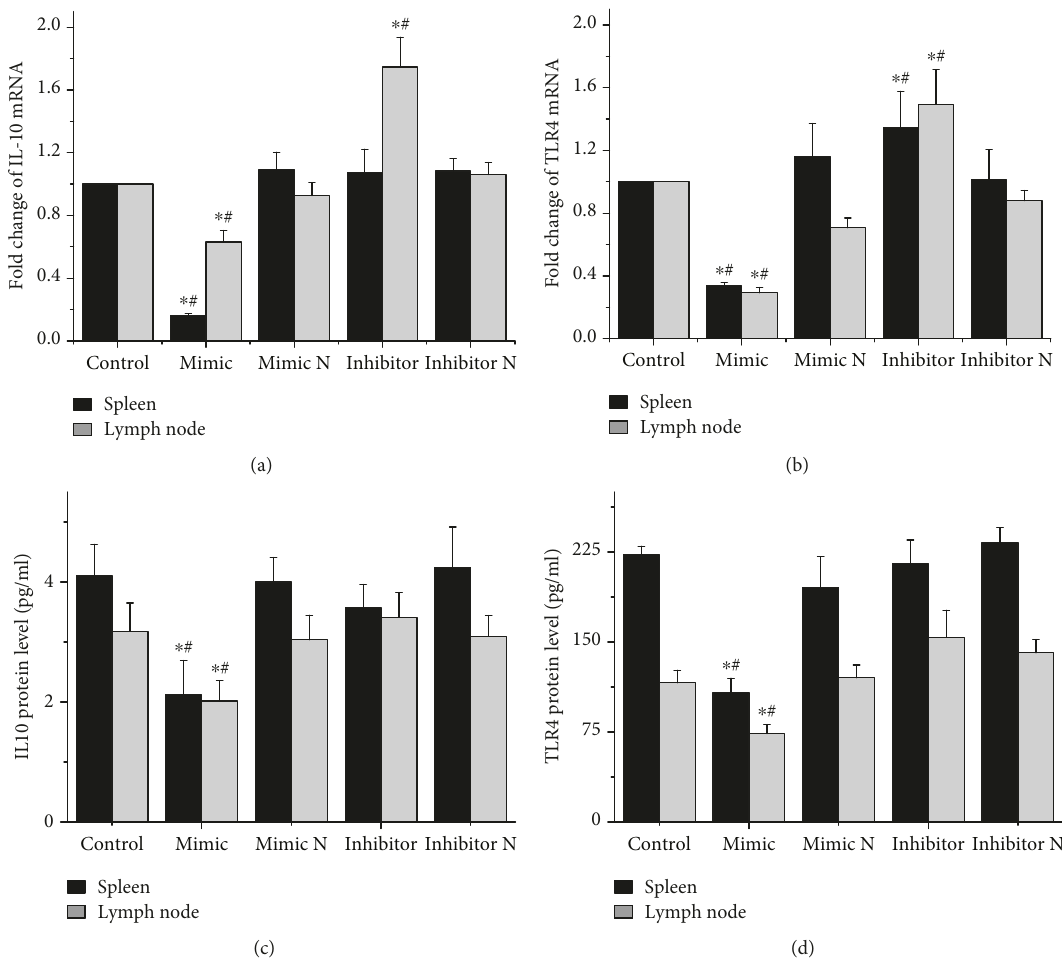
Figure 5: Expressions of IL-10 and TLR4 mRNA and proteins after treatment with rno-miR-30b-5p mimic, mimic negative, inhibitor, and inhibitor negative in spleen and lymph nodes. Note: (a), (b) expressions of IL-10 and TLR4 mRNA in spleen and lymph nodes; (c), (d) expressions of IL-10 and TLR4 proteins in spleen and lymph nodes. ∗ P < 0 05 as compared with the corresponding EAU control, # P < 0 05 as compared with the corresponding negative